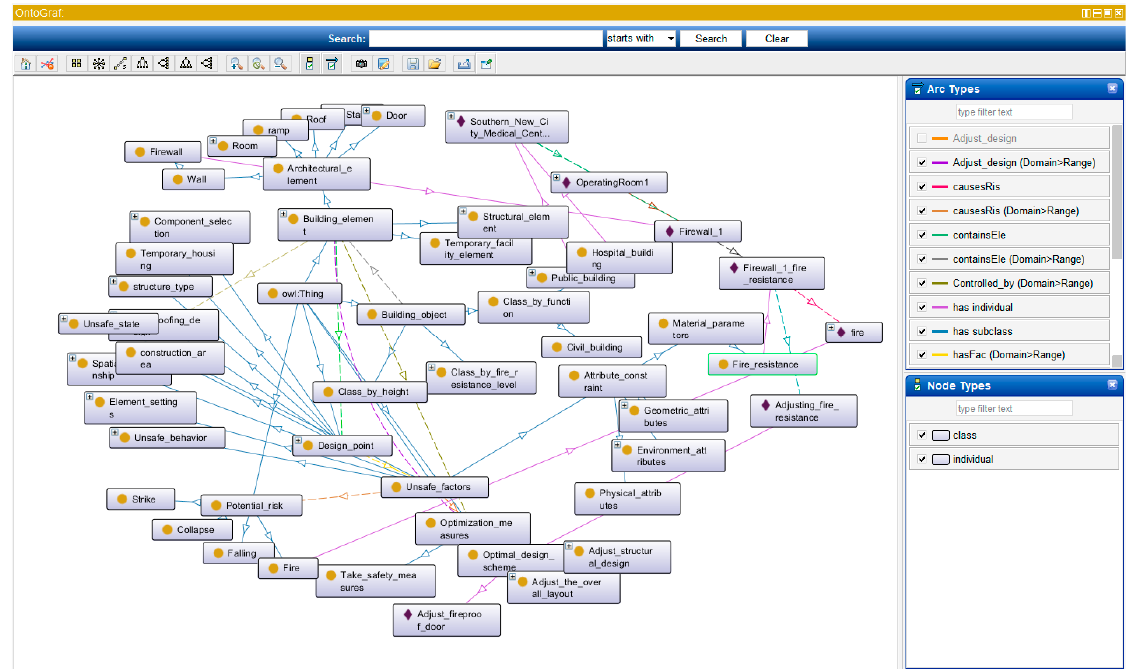
Figure 15. Ontology visualization in Ontograf of Protégé.